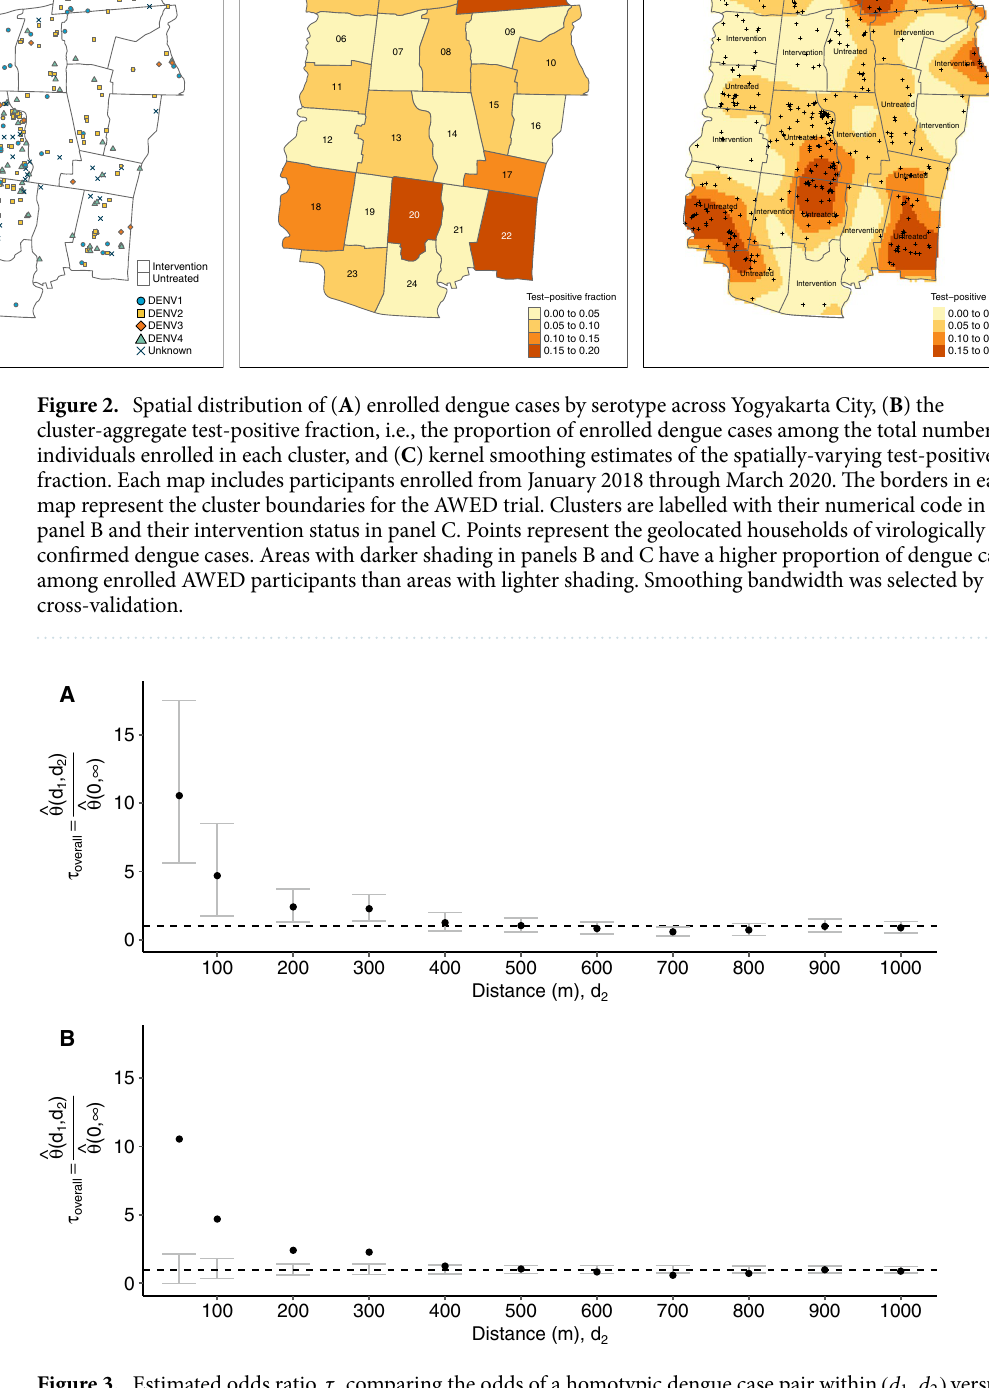
Figure 3. Estimated odds ratio, τ , comparing the odds of a homotypic dengue case pair within ( d 1 , d 2 ) versus the odds of a homotypic dengue case pair at any distance across the entire study area among participant pairs with illness onset occurring within 30 days. Variability in estimation is visualized in two distinct ways. ( A ) displays the pointwise 95% confidence interval (CI) based on 1000 bootstrap resamples of the data and ( B ) shows the pointwise 95% CI on the permutation-based null rejection region based on 1000 permutations of the